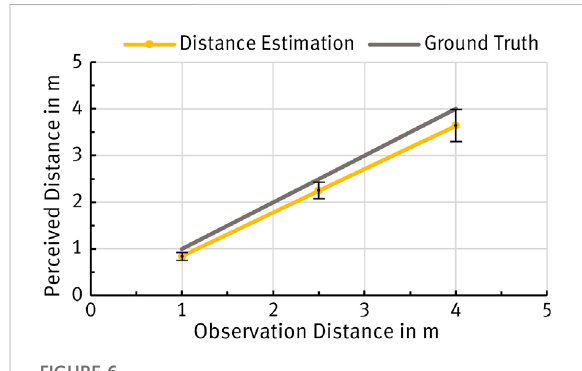
FIGURE 6 Distance estimations for our short (1 m), middle (2.5 m), and far (4 m) SODs in comparison to the ground truth. Error bars represent 95% con fi dence intervals.